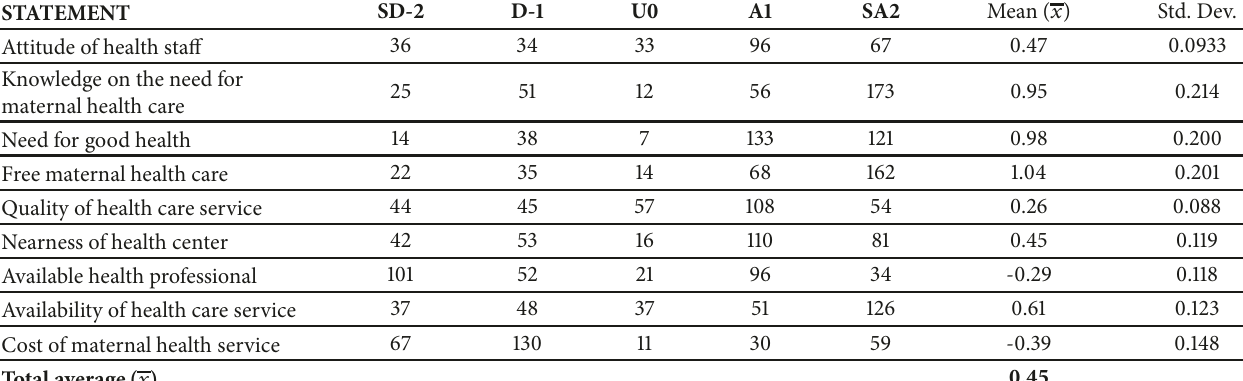
Table 6: Reasons for women’s use of